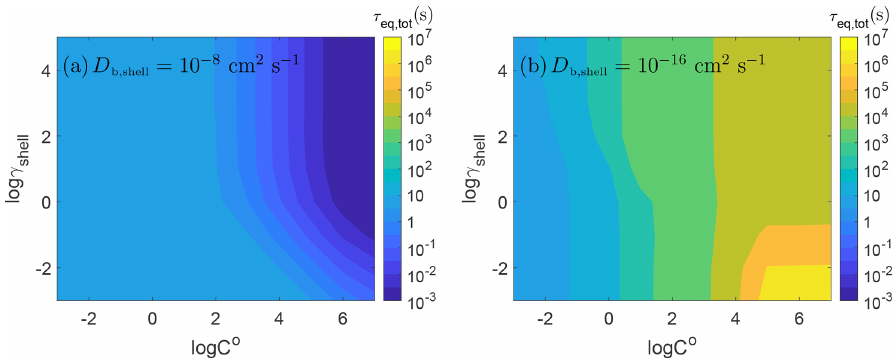
Figure 4. Equilibrium timescales of SOA partitioning as a function of pure compound saturation mass concentration ( C 0 ) and the activity co- efficient of the condensing species in the shell ( γ shell ) with bulk diffusivity of (a) D b , shell = 10 − 8 cm 2 s − 1 and (b) D b , shell = 10 − 16 cm 2 s − 1